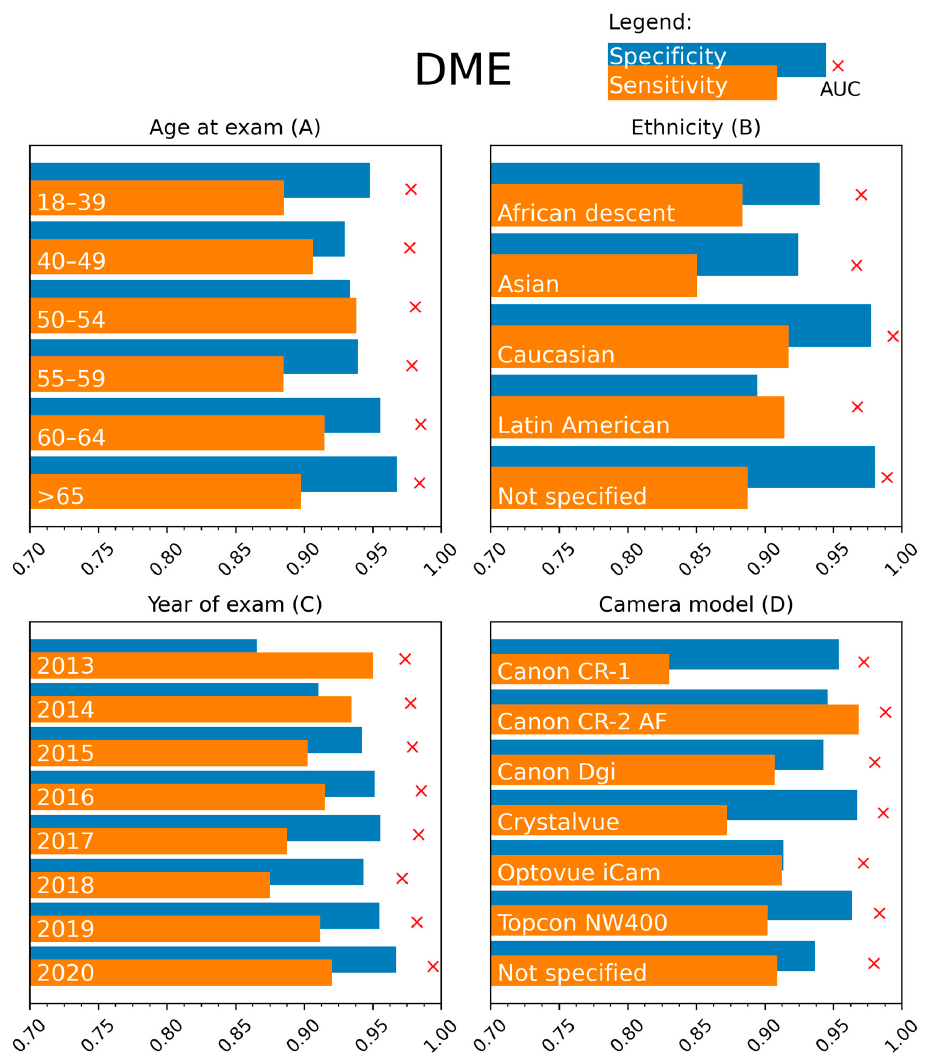
Figure 3. Stratification results: sensitivity (orange), specificity (blue) and AUC (red cross) for DME detection for different subgroups of the test set. The subgroups were created based on presented metadata, namely age at the exam (in years), ethnicity, year of exam, and camera model. A high sensitivity (exceeding 90% on average) for detecting referable DR is obtained for most age groups, with only a decreased sensitivity of 82.51% (95% confidence intervals can be found in Appendix A) in the 65+ age group. Specificity remained high at 94.24% in this age group. No differences between the age groups are encountered for DME detection.